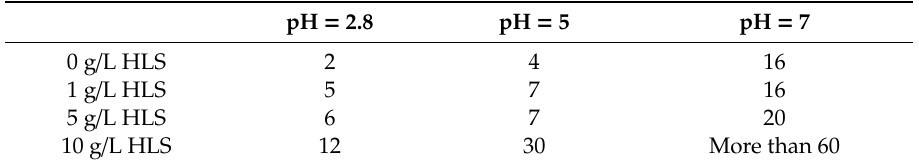
Table 1. Removal of pentachlorophenol (PCP) (1 mg/L) by photo-Fenton driven under simulated sunlight without Pyrex filter at different pH with or without HLS. The t 50% are given in min. pH = 2.8